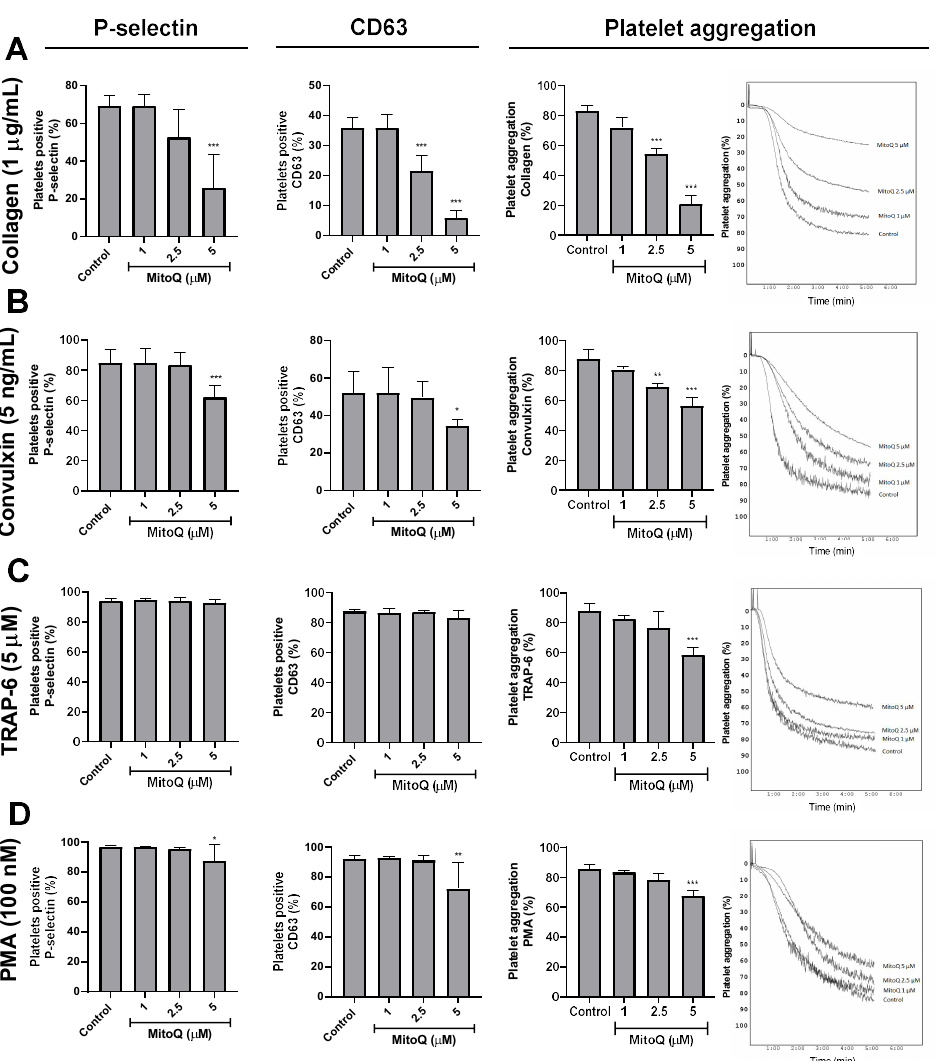
Figure 3. E ff ect of MitoQ on P-selectin and CD63 expression, and platelet aggregation. E ff ect of MitoQ on the expression of P-selectin and CD63, and platelet aggregation in human platelets stimulated by collagen ( A ), convulxin ( B ), TRAP-6 ( C ), and PMA ( D ). In P-selectin and CD63 assays, platelets were identified as CD61 + population and from these populations expressing the CD61 were analyzed in terms of percentage of the platelets with CD62 + (P-selectin) or CD63 + . Representative dot plots of P-selectin and CD63 assays were included as Supplementary Figures S6 and S7. The statistical analysis was performed using the ANOVA (Tukey test). * p < 0.05, ** p < 0.01 and *** p < 0.001.